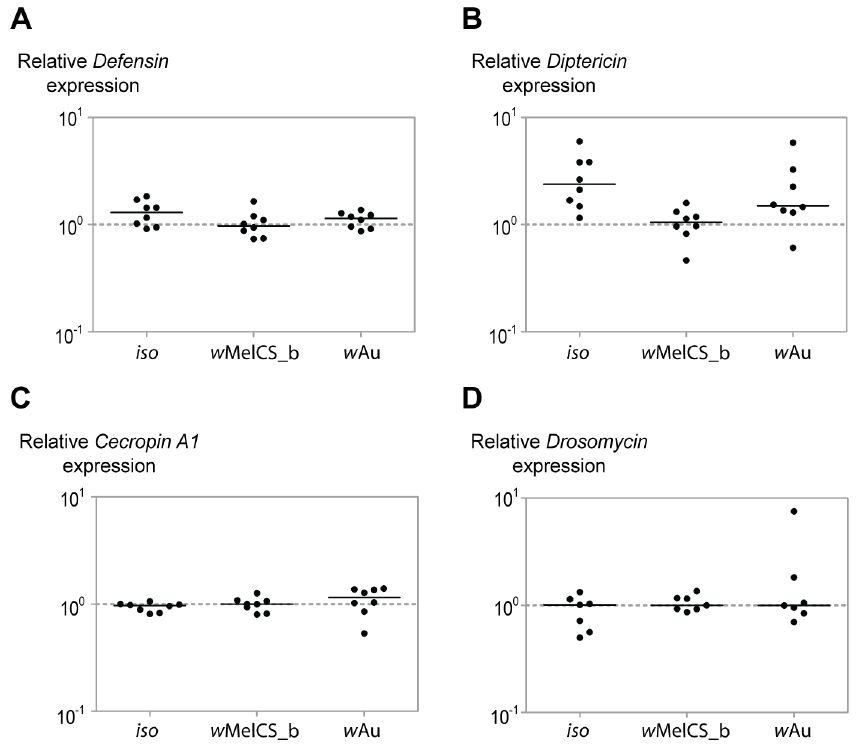
Figure 3. Expression of antimicrobial peptide genes in Wolbachia -free iso , w Au and w MelCS_b harbouring flies. qRT-PCR on the RNA collected from 3–6 days-old whole flies performed with the primers specific for Defensin (A), Diptericin (B) Cecropin A1 (C) and Drosomycin (D). Relative expression of the host antimicrobial peptide genes was calculated using host Rpl32 as a reference. Values are relative to median of samples of w MelCS_b. The only statistically significant difference is in Diptericin gene expression between iso and w MelCS_b (pairwise Wilcoxon rank sum test,